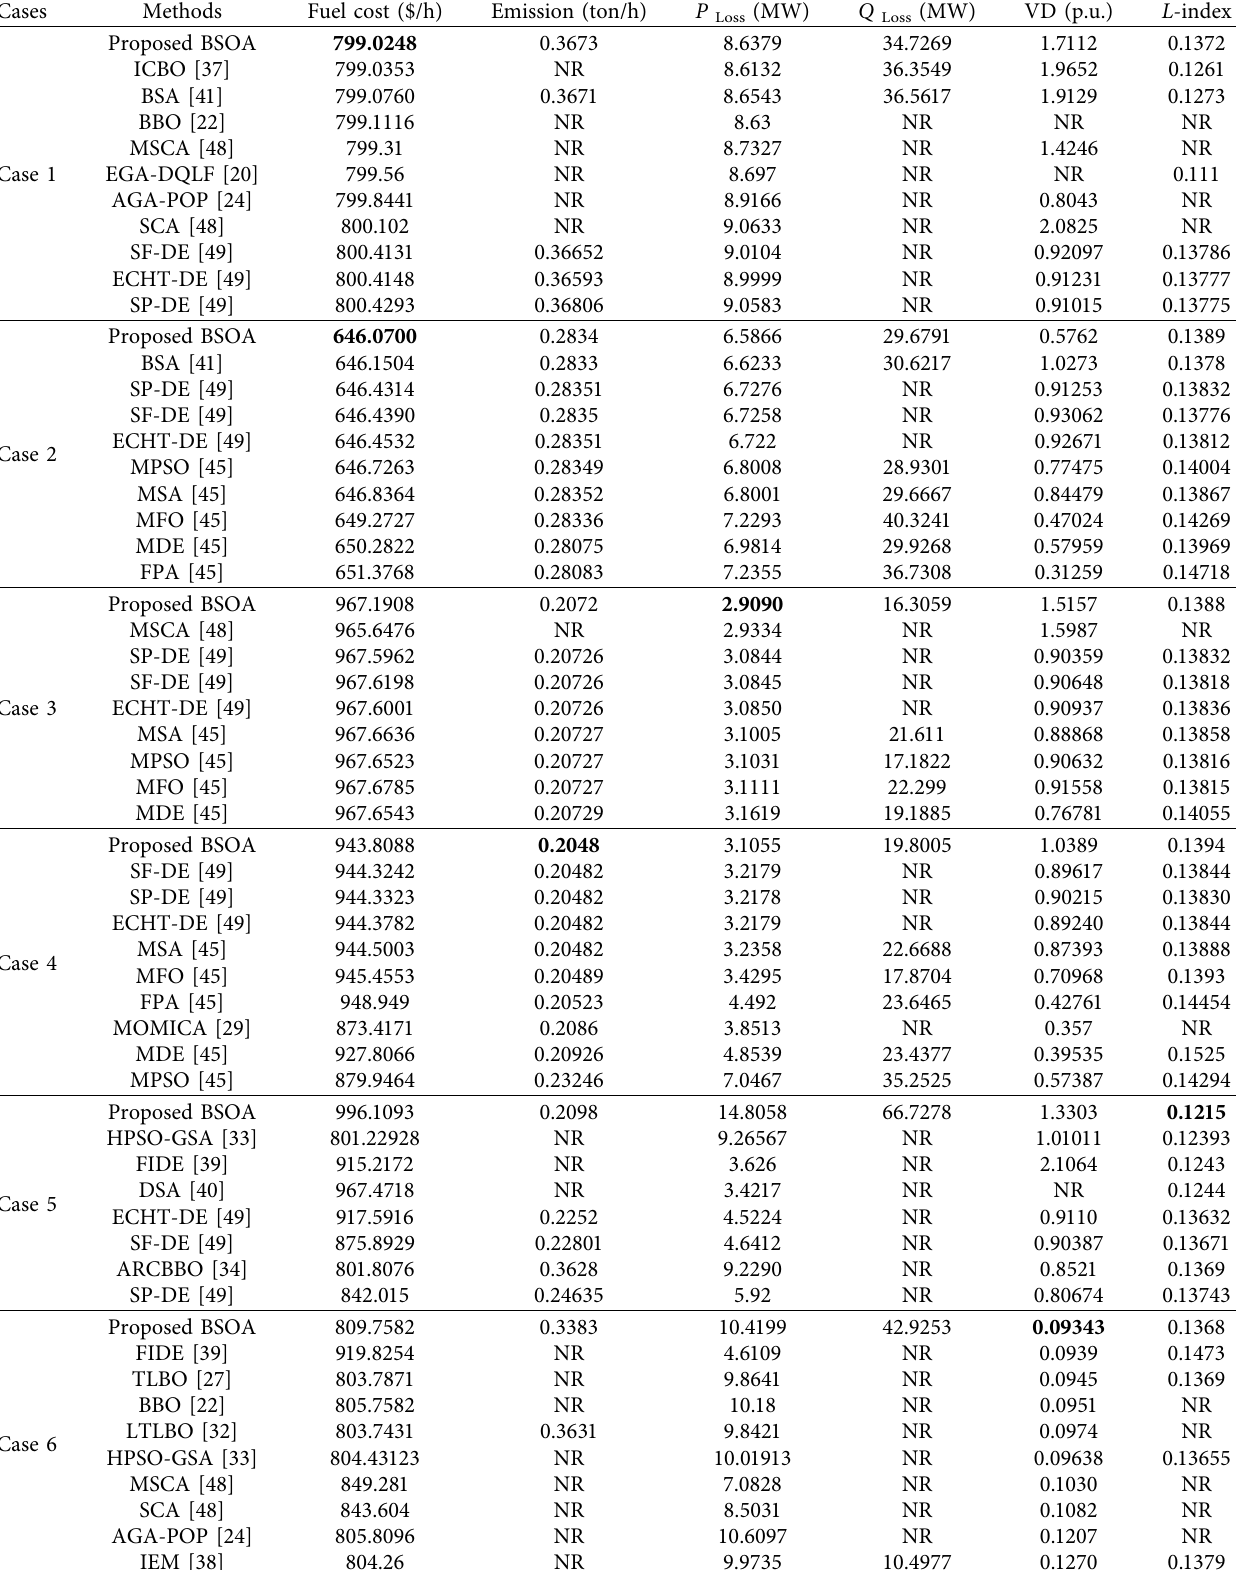
NR ∗ -Not reported. Te best objective values are highlighted in the bold